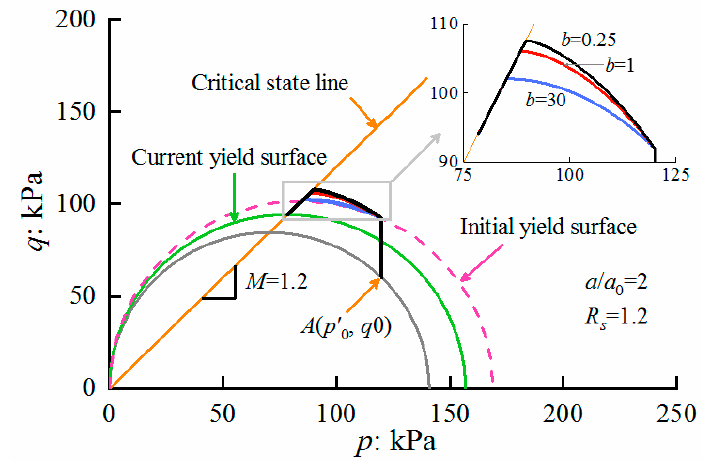
Figure 14. Effects of structural parameter b on the effective stress paths.